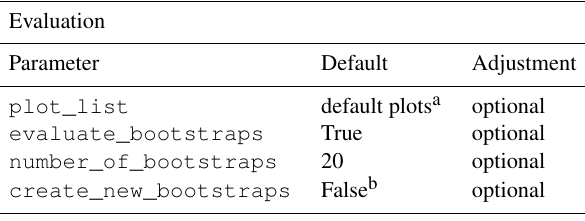
Table 5. Summary of all parameters related to the evaluation that are required, recommended, or optional to adjust for a custom ex- periment workflow.